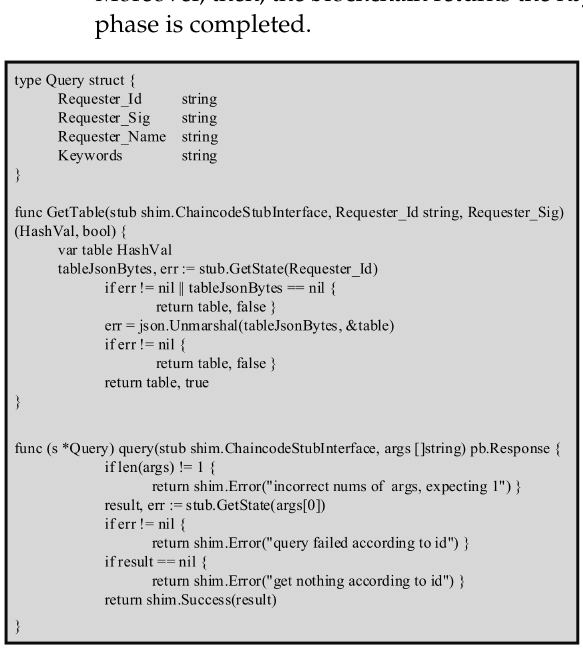
Figure 6. Chaincode Querfile of the proposed